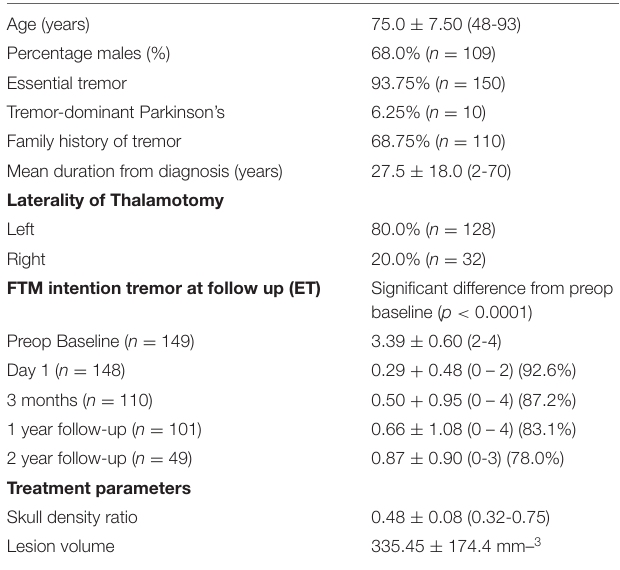
TABLE 1 | Demographics and clinical data of included patients ( n =